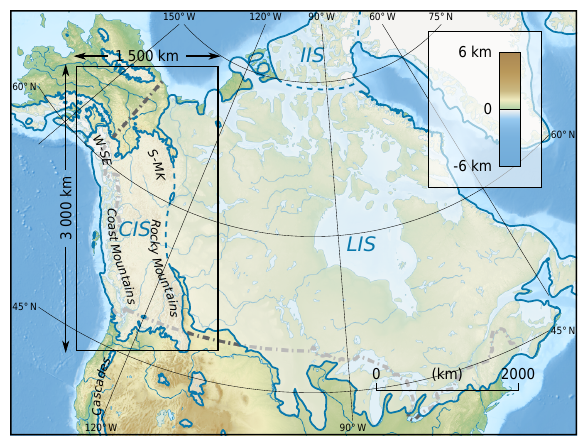
Figure 1. Shaded relief map of northern North America with the ex- tent of the Cordilleran (CIS), Laurentide (LIS) and Innuitian (IIS) ice sheets at 14 14 CkyrBP (16.8calkyrBP) (Dyke, 2004). While this age denotes the LIS after retreat from its LGM, it closely cor- responds to the LGM extent of most of the Cordilleran ice sheet (Porter and Swanson, 1998; Dyke, 2004; Stroeven et al., 2010). The rectangular box denotes the modelling domain of the Cordilleran ice sheet of 1500 by 3000km. Major mountain ranges covered by the ice sheet include the Wrangell and Saint Elias mountains (W– SE), the Selwyn and MacKenzie mountains (S–MK), the Coast Mountains and the Rocky Mountains. The background map consists of ETOPO1 (Amante and Eakins, 2009) and Natural Earth Data (Patterson and Kelso, 2010) and was assembled with GRASS GIS (Neteler et al.,